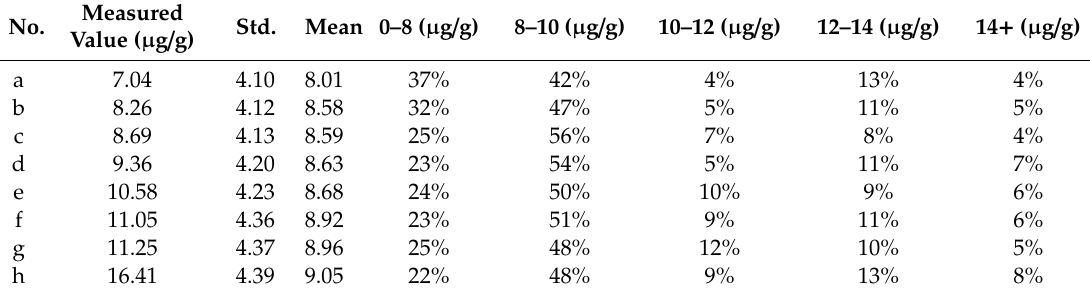
Table 4. Statistical summary of the TAs distribution maps